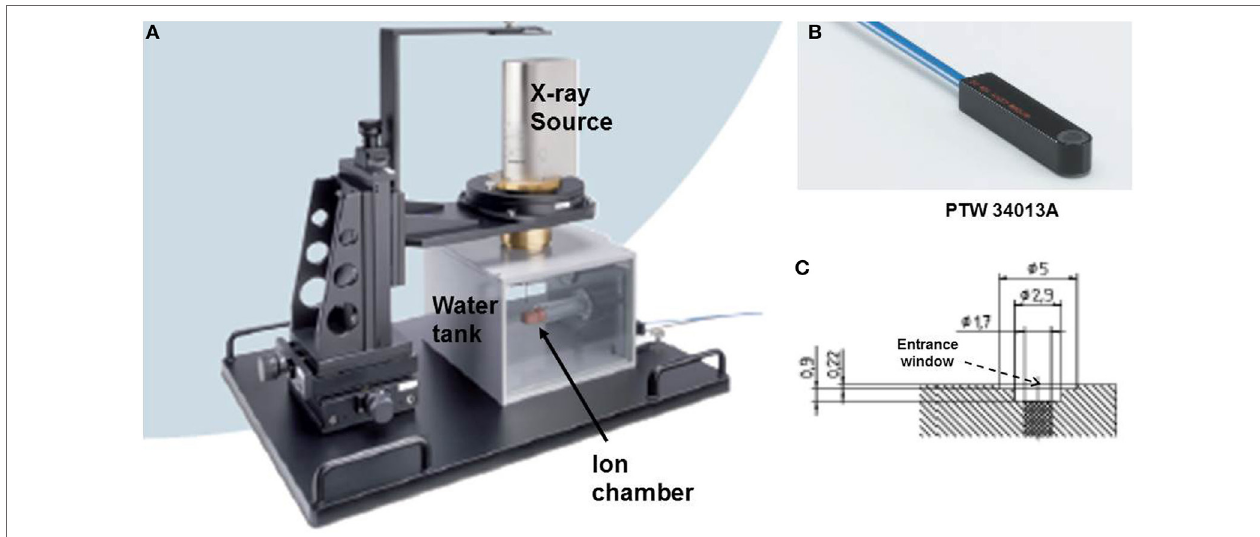
FigUre 2 | Measurement setup for dose output factor, OF and depth dose profiles, DD. (a) Water tank showing positions of ion chamber and X-ray source; (B) PTW34013A thin-window parallel plate ion chamber used for dose measurements; (c) a schematic diagram of the parallel plate ion chamber showing beam entrance window (thickness = 0.22